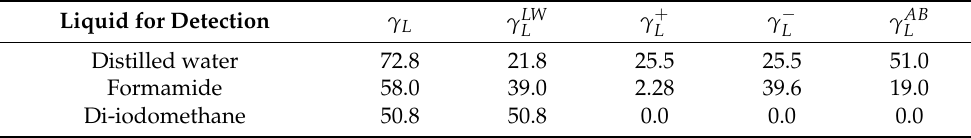
Table 3. Surface tension γ of each probe liquid and its components (mJ/m 2